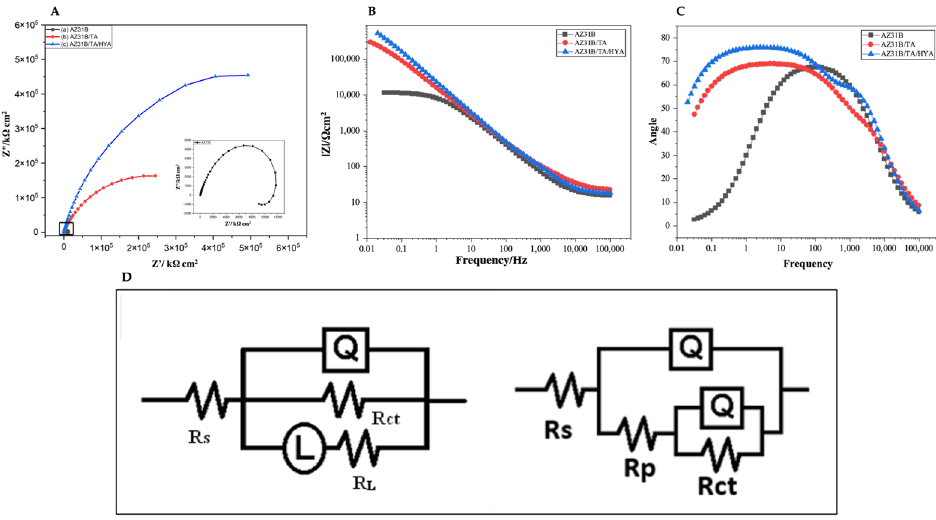
Figure 6. ( A ) A nyquist curve on the samples AZ31B, AZ31B/TA, and AZ31B/TA/HYA; ( B ) Bode impedance plot on the samples AZ31B, AZ31B/TA, and AZ31B/TA/HYA; ( C ) Bode phase plot on the samples AZ31B, AZ31B/TA, and AZ31B/TA/HYA; and ( D ) Equivalent electrical circuit ( left ) AZ31B without coating; ( right ) AZ31B with coating.